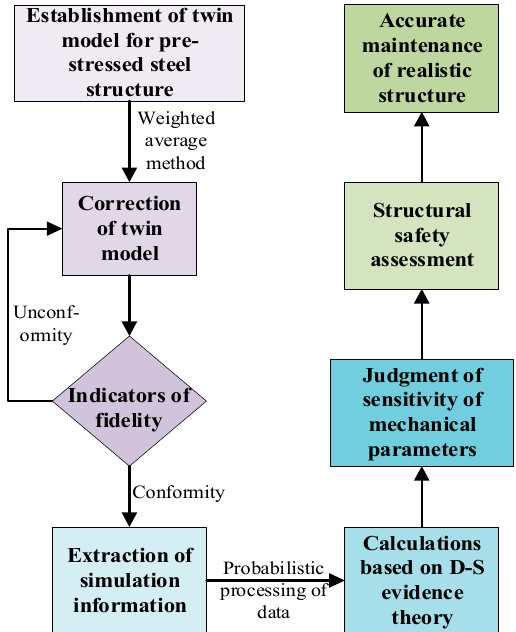
Figure 4. Safety performance assessment and maintenance process for struc- tures.